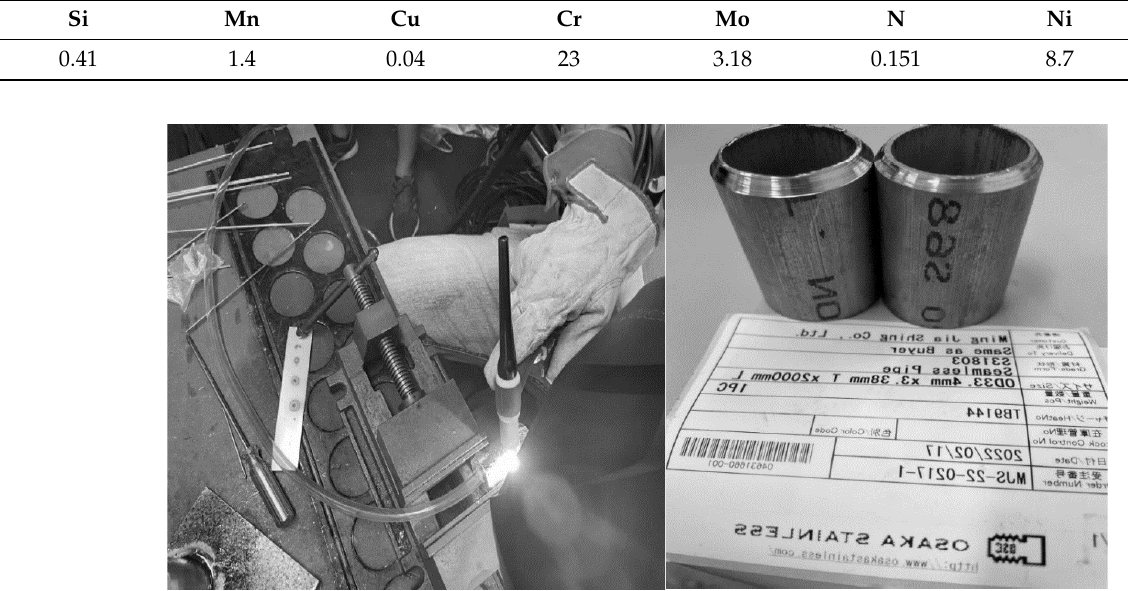
Figure 1. Actual welding diagram of GTAW process for duplex stainless steel pipe.